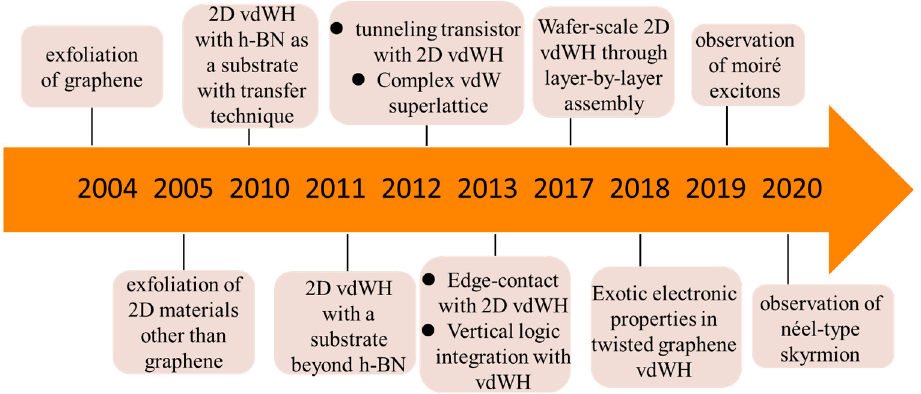
Figure 1. Important events in the progress of 2D